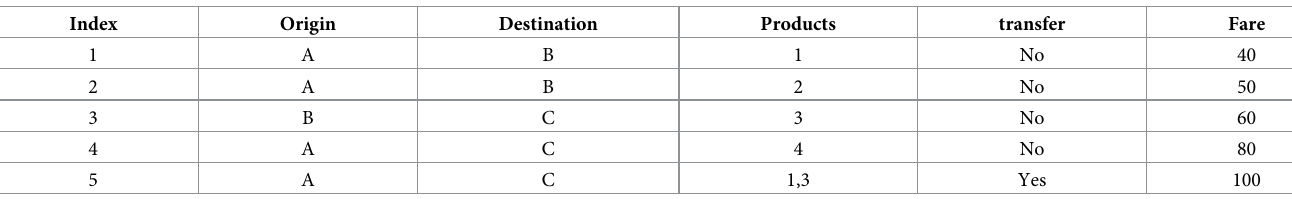
Table 4. List of itineraries in the example